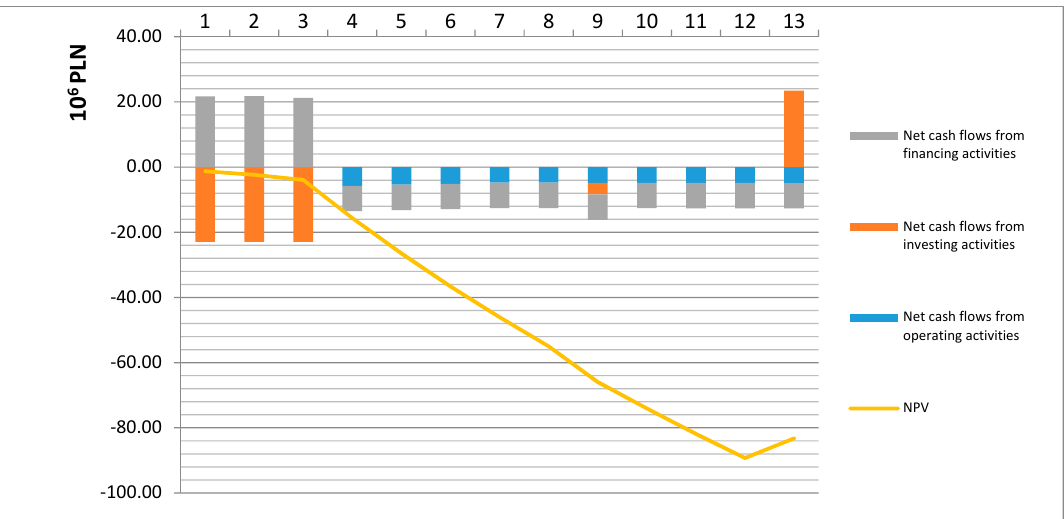
Figure 4. Cash flows and the net present value (NPV) during the investment implementation period and the system operating period.